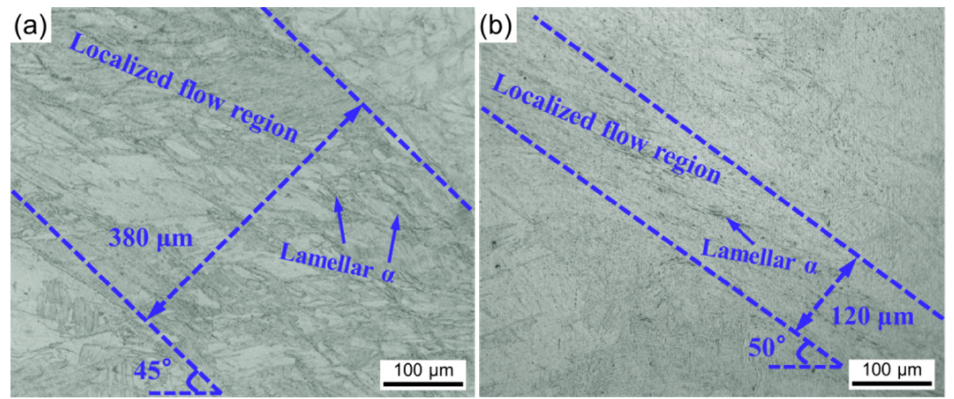
Figure 13. The microstructure of cross section of the compressed specimens for ( a ) basket-weave microstructure and ( b ) widmannstatten microstructure under 50 A/mm 2 . microstructure and ( b ) widmannstatten microstructure under 50 A/mm 2